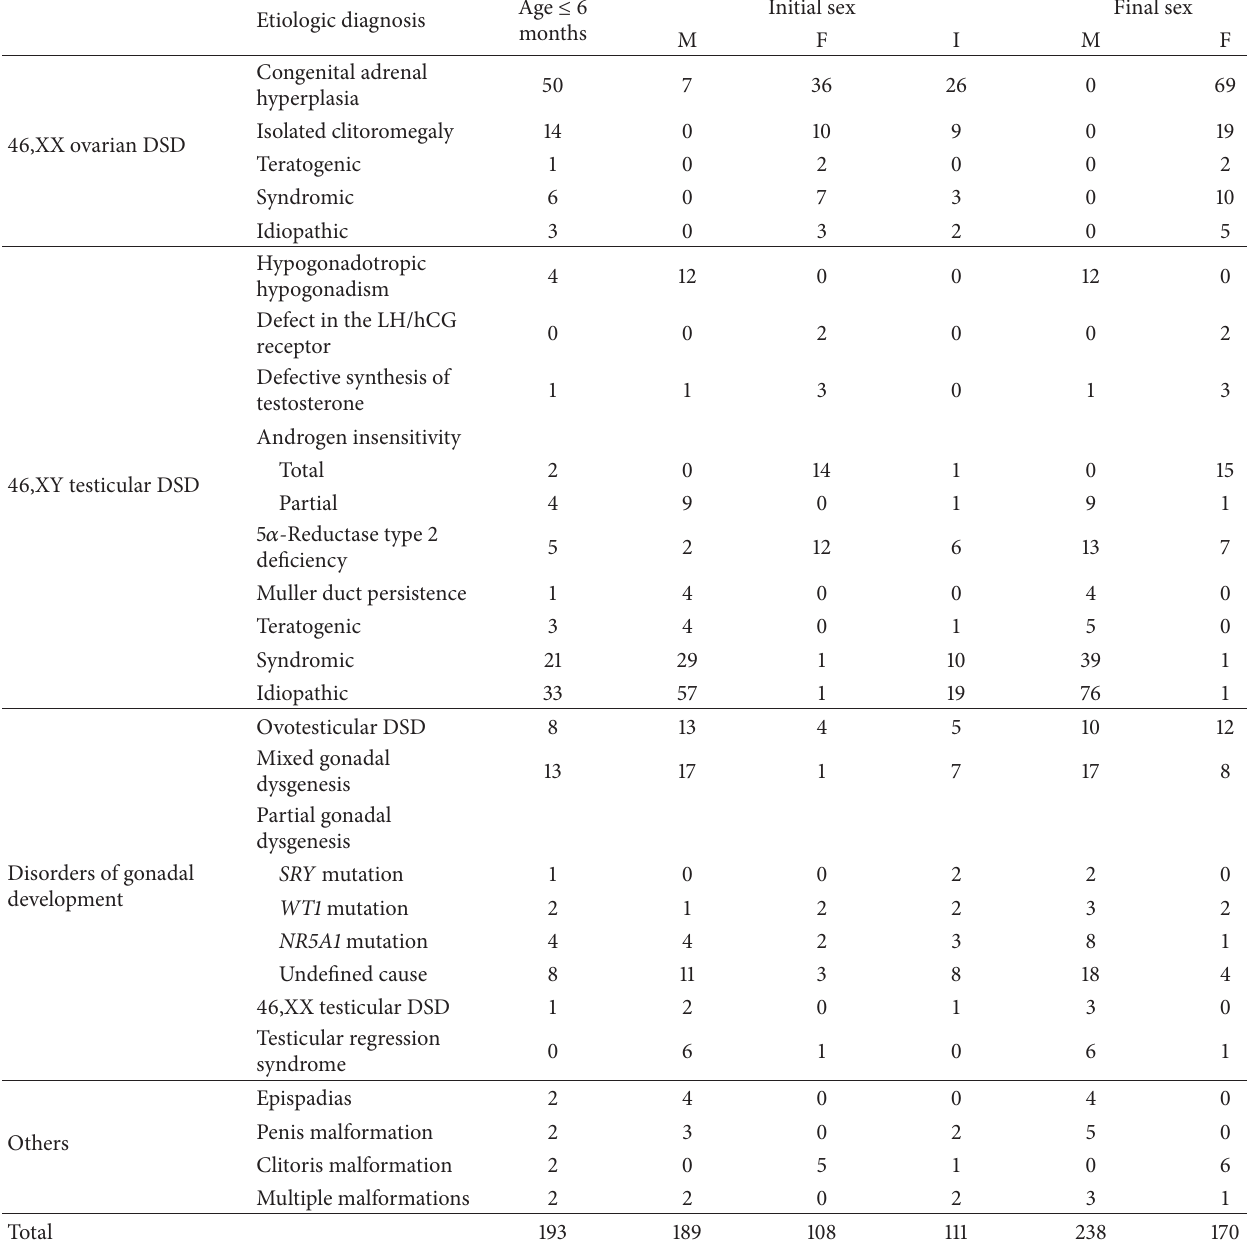
Table 2: Frequencies of initial and final sex distributed according to aetiologic diagnosis of 408 consecutive cases of DSD with ambiguous genitalia followed at GIEDDS, UNICAMP, between January 1989 and December 2011.